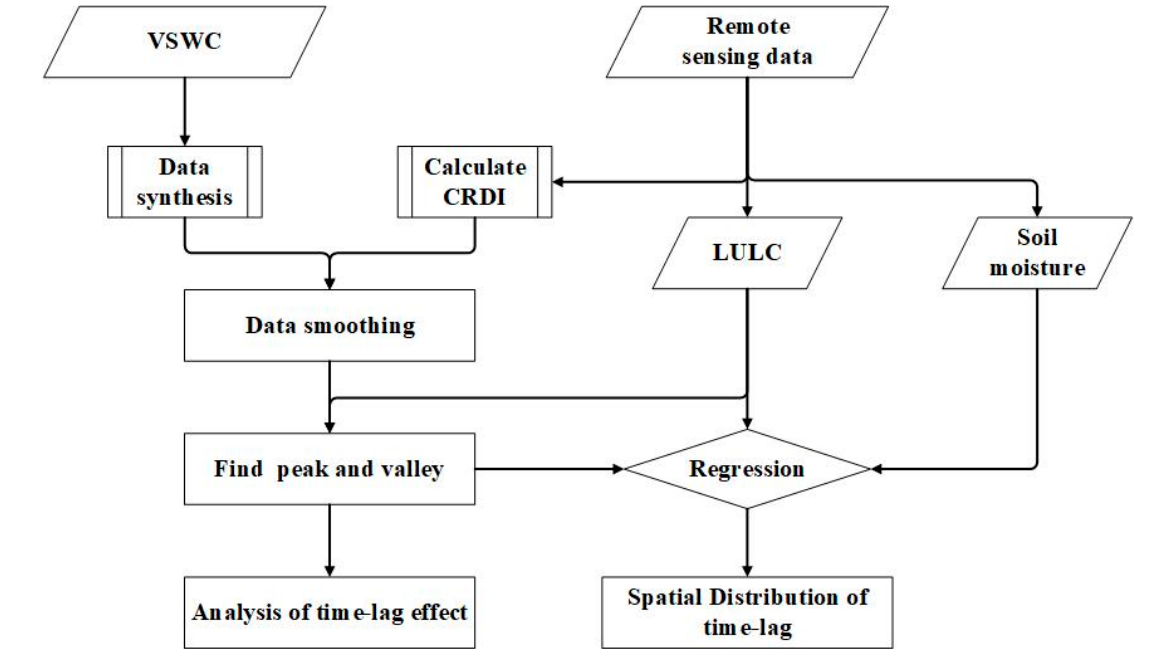
Figure 2. Framework for the time-lag effect of vegetation on VSWC.